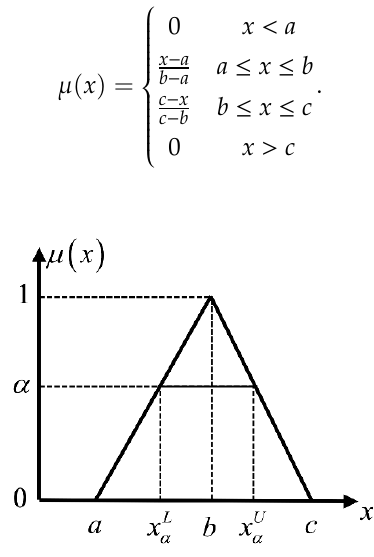
Figure 1. Triangular fuzzy number and its α -cut.